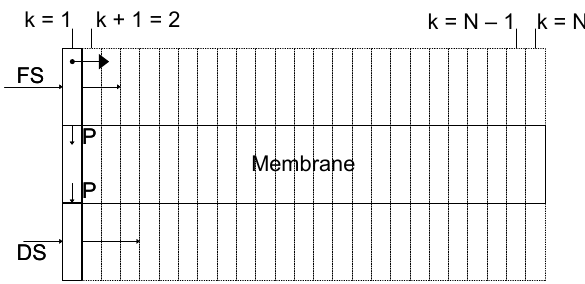
Figure 3. Scheme of material transport for a given membrane cross ‐ section.